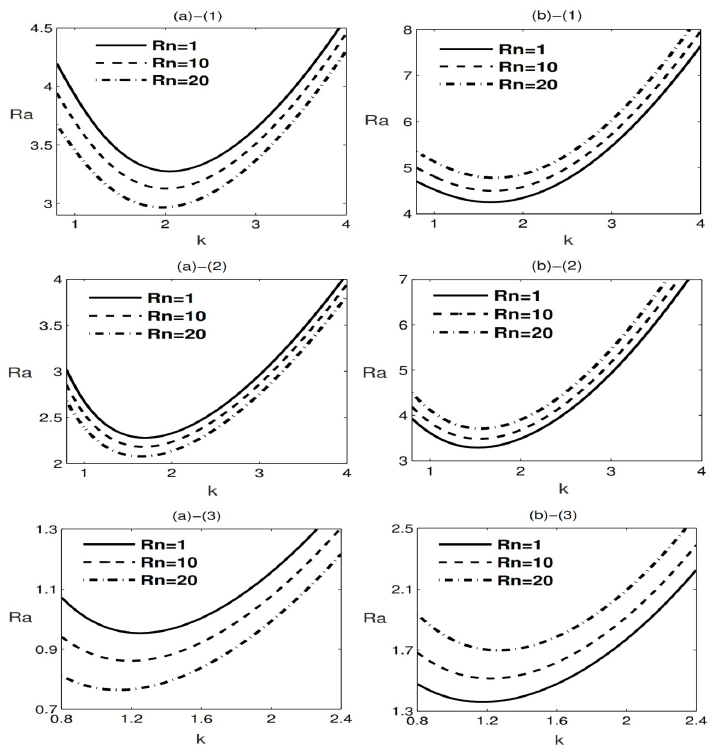
Figure 5: Neutral stability curves for distinct values of Rn for (a) 1 J = + and (b) 1 J = − ; for (1) I_C-I_C, (2) I_C-I_CHF, and (3) I_C-F_CHF